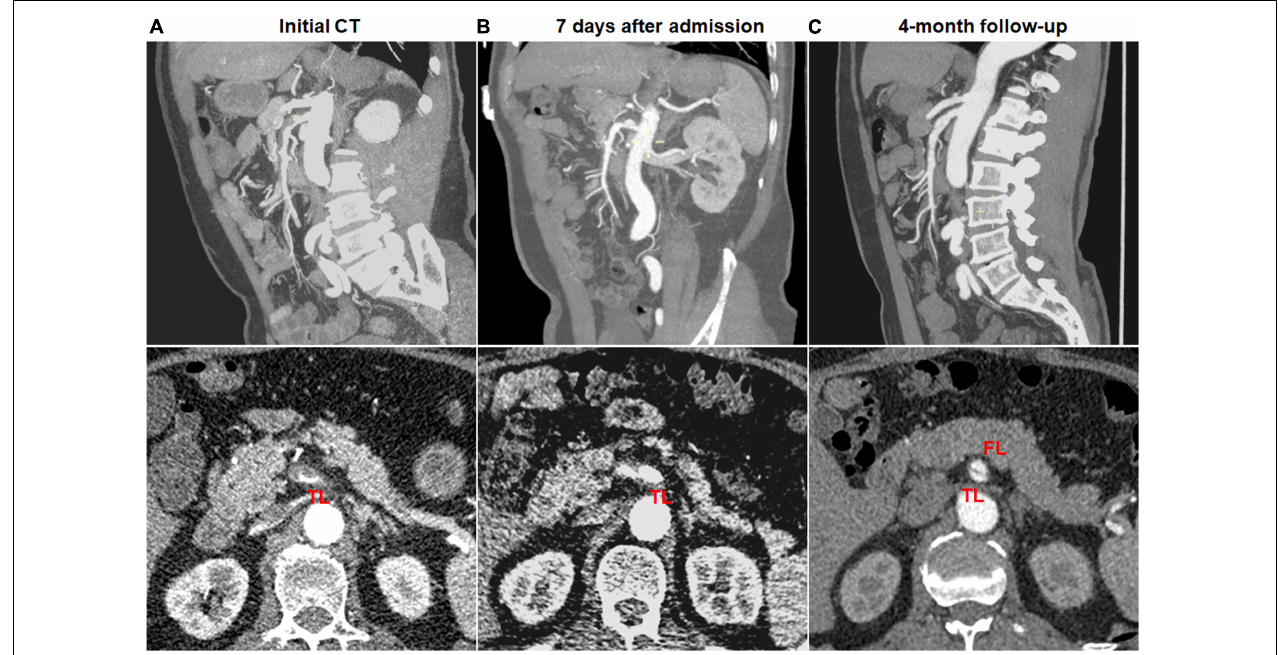
FIGURE 7 | Type change of type III spontaneous isolated superior mesenteric artery dissection on follow-up computed tomography (CT) angiography. (A) Initial CT angiography showed the thrombosed false lumen with ulcer-like projection (ULP) in a 49-year-old man. (B) One week after conservative management, the thrombosis of false lumen was partially resolved and true lumen was slightly dilated. (C) Follow-up angiogram at 4 months after conservative treatment showed double-lumen sign on an axial view and a patent “cul-de-sac” shaped false lumen without re-entry on a sagittal view (type II dissection).